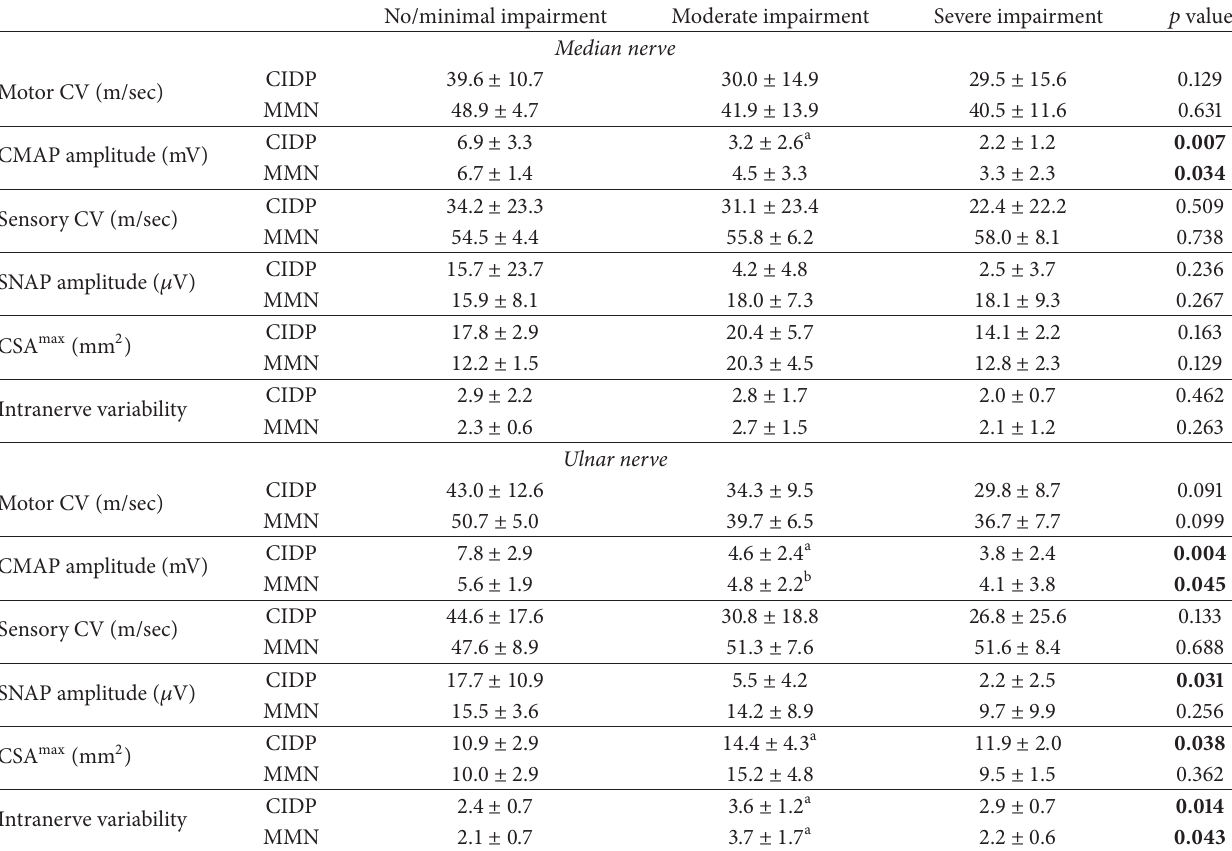
Table 4: Clinical, neurophysiological, and ultrasonographic data: upper